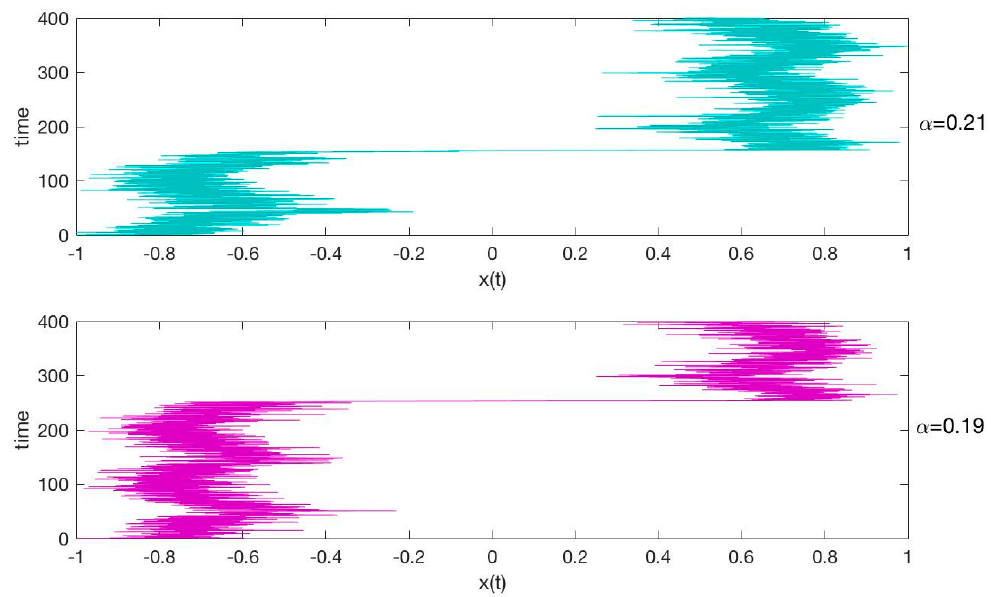
Figure 11. Comparison between the two analysed configurations, i.e., for V 0 = 0 on the top and V 0 = 2 on the bottom when the amplitude of the external periodic perturbation is a = 0.3. As can be seen, while for V 0 = 0 the threshold jump occurs at a noise level of α = 0.21, for V 0 = 2 the threshold jump occurs at α = 0.19.